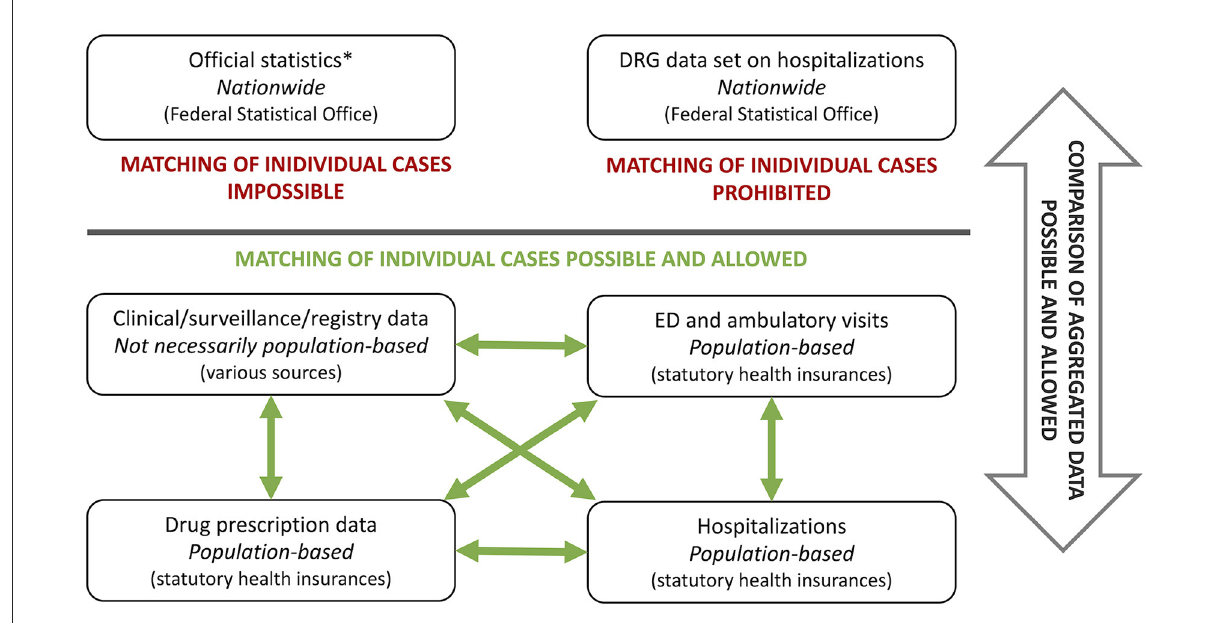
FIGURE1 Different types of administrative data sets and possibilities of data linking using Germany as an example. DRG, diagnose related groups; ED, emergency department; *publicly